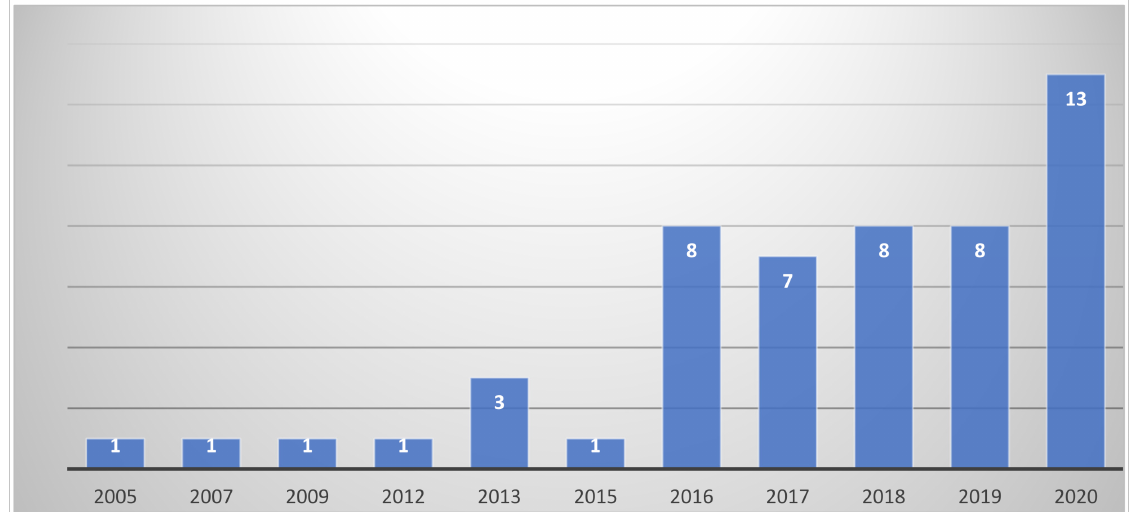
Figure 2. Distribution of literature in the publication each